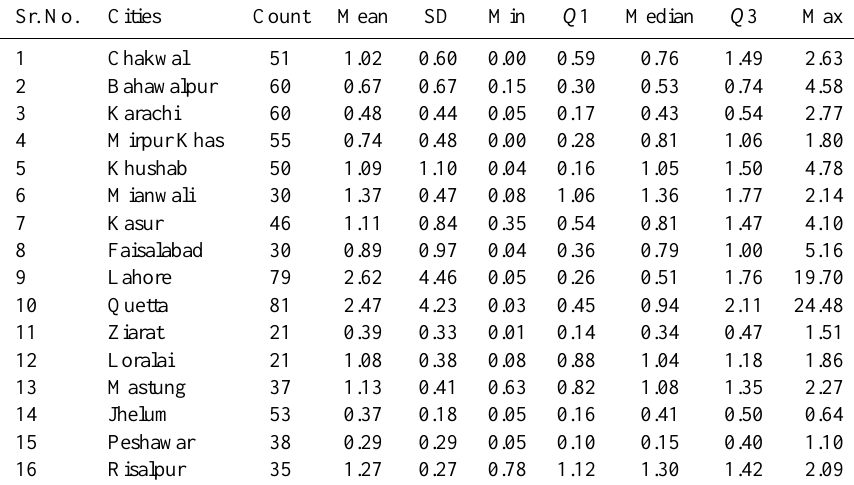
Table 2. Basic statistics of fluoride in water sources of 16 cities.